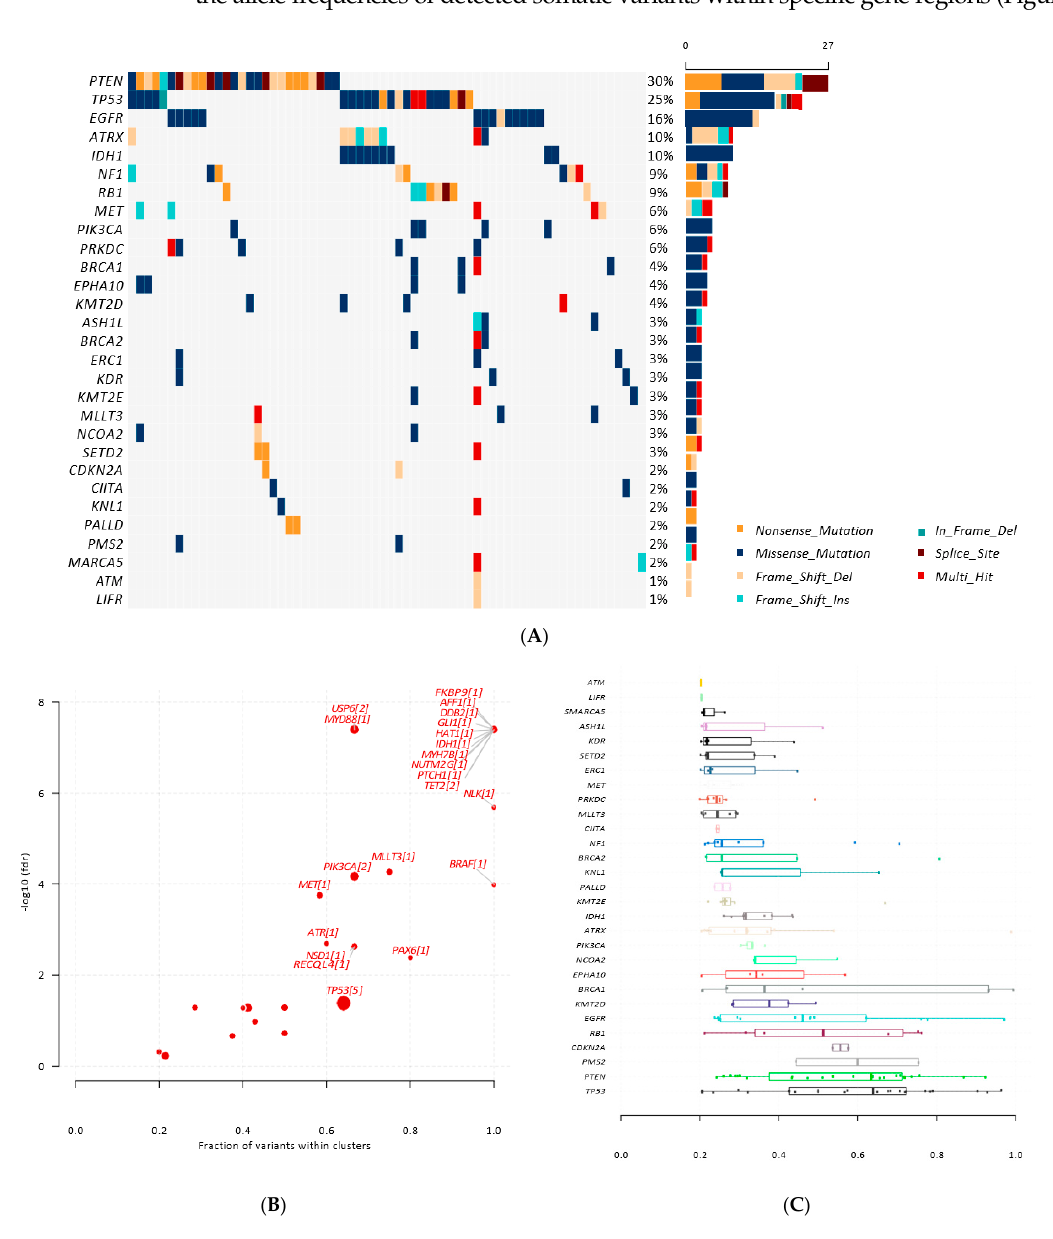
Figure 5. Somatic variants found in the tDNA: ( A ) mutational landscape plot of somatic variants found in the tumor tissue; ( B ) plot with size of the points proportional to a number of SNV clusters found in the gene. The x -axis indicates a fraction of the total variants identified in these clusters. Gene names are labeled along with the number of clusters found; ( C ) allele frequency variation between analyzed samples within a specific gene region.